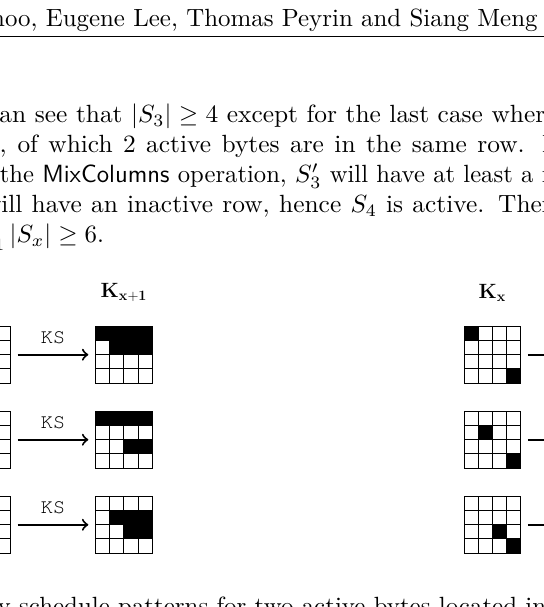
Figure 9: Key schedule patterns for two active bytes located in the same